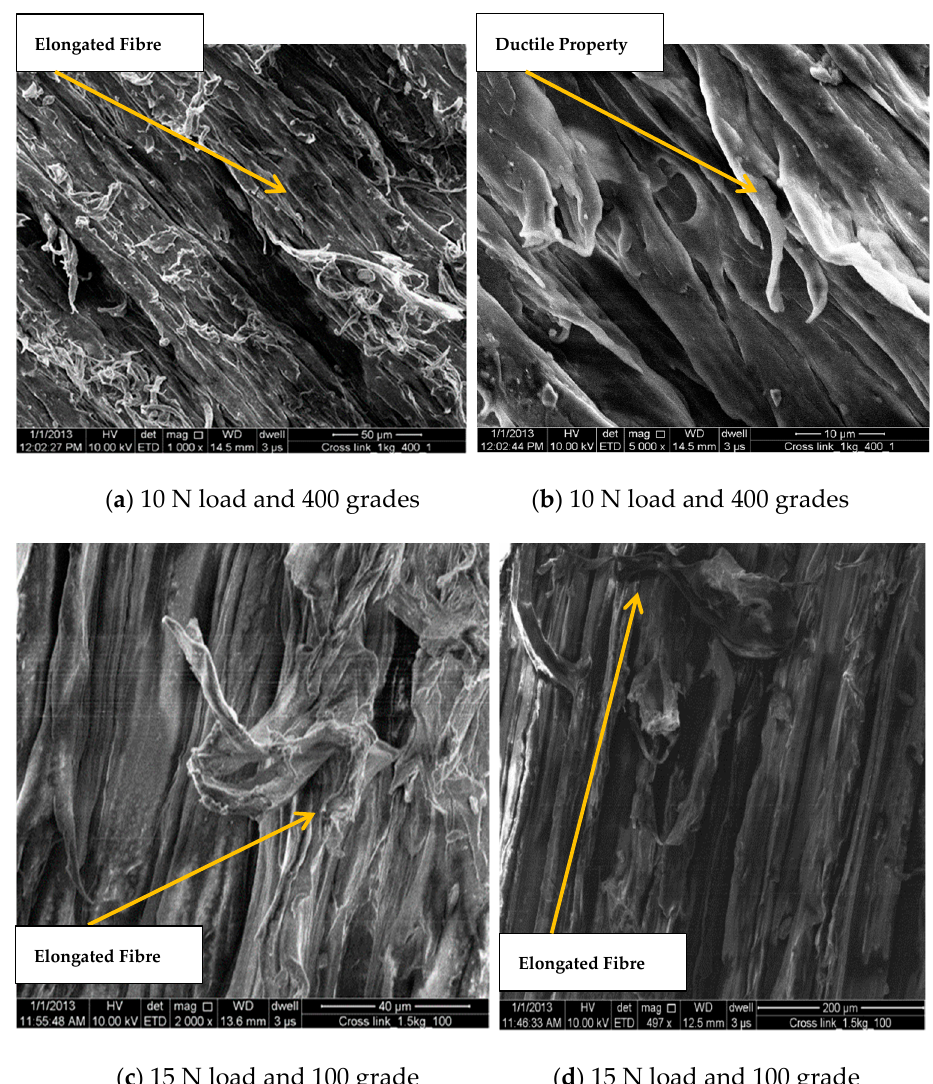
Figure 8. SEM analysis of XLPE at different load and grade conditions.